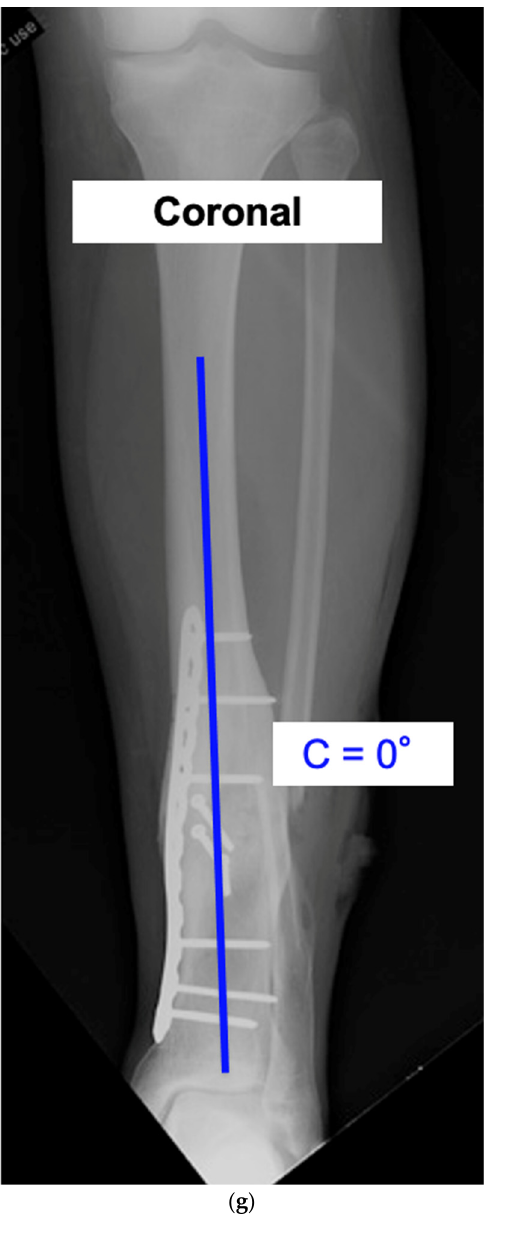
Figure 8. See Case 2 description for details of a tibial malunion. ( a – h ) calculate the variables θ (Osteotomy Angle) and φ (Starting Point Angle) to derive the mathematically directed osteotomy. Intraoperative and postoperative radiographs reveal successful correction of the deformity and osteotomy union.